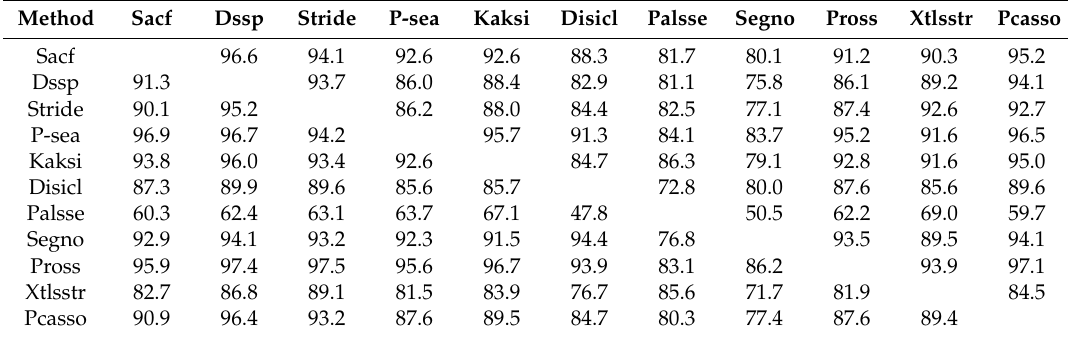
Table 2. SOV scores (%) between any two of the eleven programs on Set T for helix. For every SOV score in the table, the corresponding method in the first column is taken as the reference method.